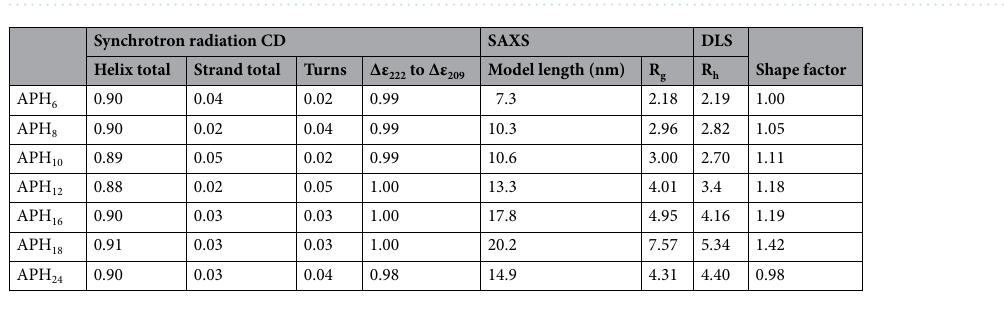
Table 1. Biophysical parameters for APH